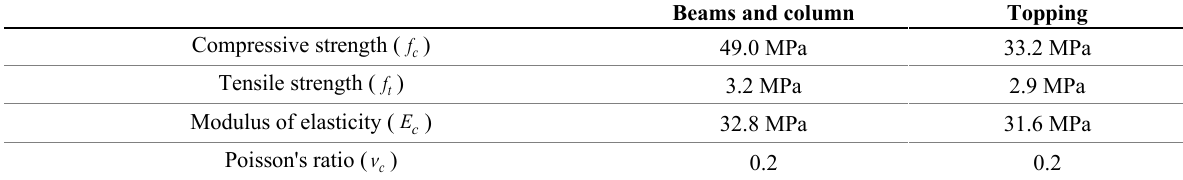
Table 2. Mechanical characteristics of concretes